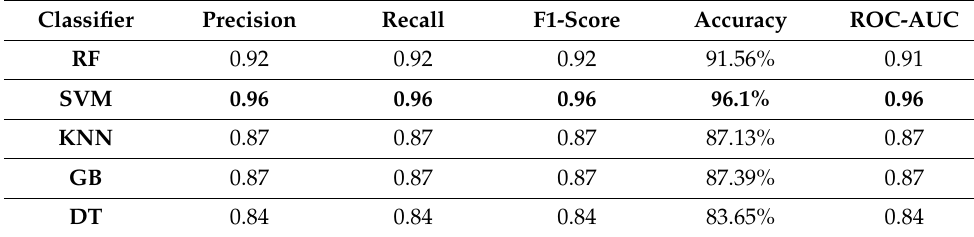
Table 3. Results before parameter